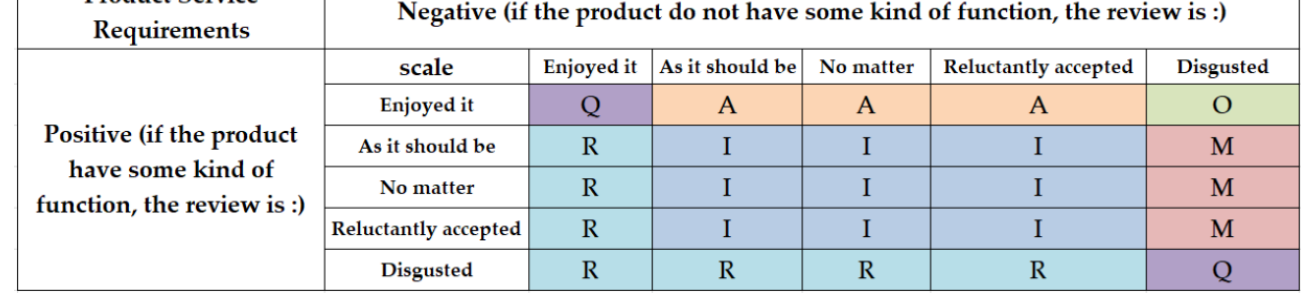
Figure 2. KANO evaluation results classification comparison. A: Attractive attribute; R: Reverse at- KANO evaluation results classification tribute; M: Mandatory attribute; I: Indifference attribute; O: Desired attribute; Q: Questionable at- tribute.